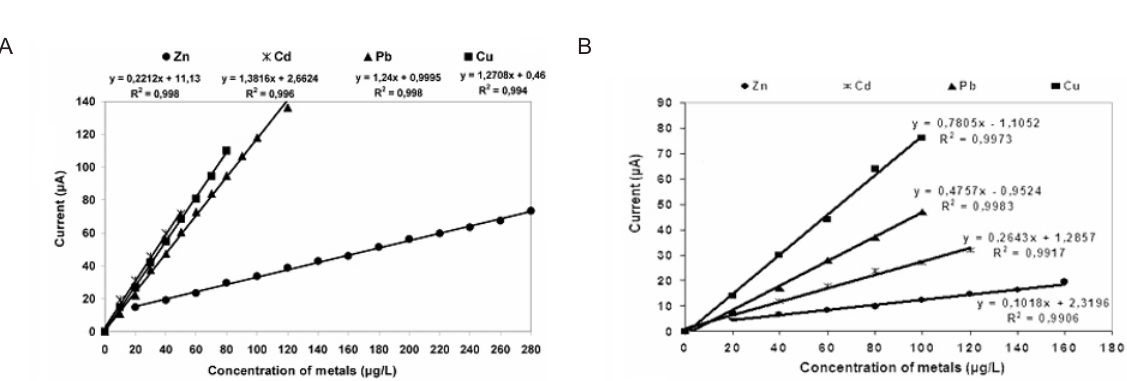
Figure 2. Calibration plots for increasing concentration of (A) copper, lead, cadmium in 10 μg L -1 steps and of zinc in 20 μg L -1 steps at the GCE and of (B) copper, lead, cadmium and zinc in 20 μg L -1 steps at the CFE.